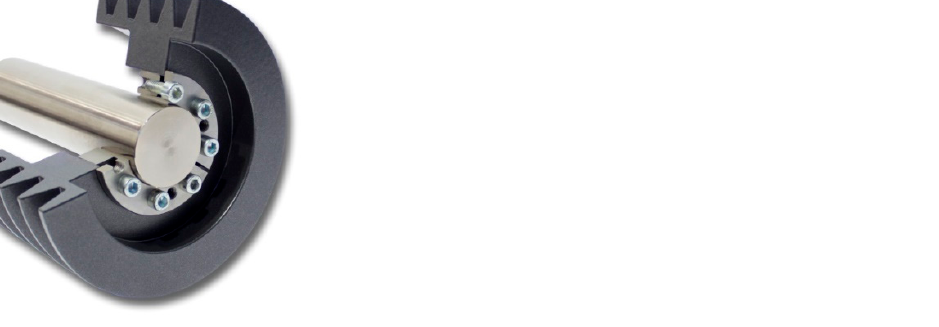
Figure 10. Shaft–hub connection with a cone clamping element (hub clamped on the inside) from RINGSPANN GmbH (Image source: RINGSPANN GmbH).